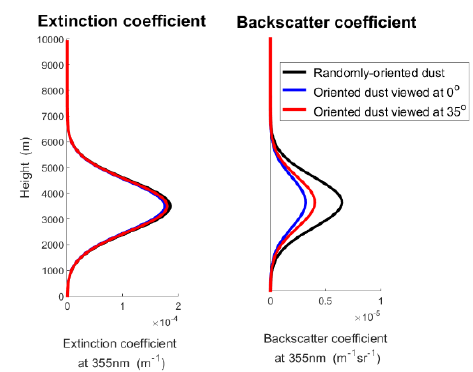
Figure 3: Simulations of the extinction coefficient (left) and backscatter coefficient at 355 nm (right) as a function of altitude for a layer of randomly oriented (black line) and vertically oriented particles (blue and red lines). For oriented particles, the extinction and backscatter coefficients viewed with a lidar at 0 o are denoted with blue and viewed at 35 o with red.